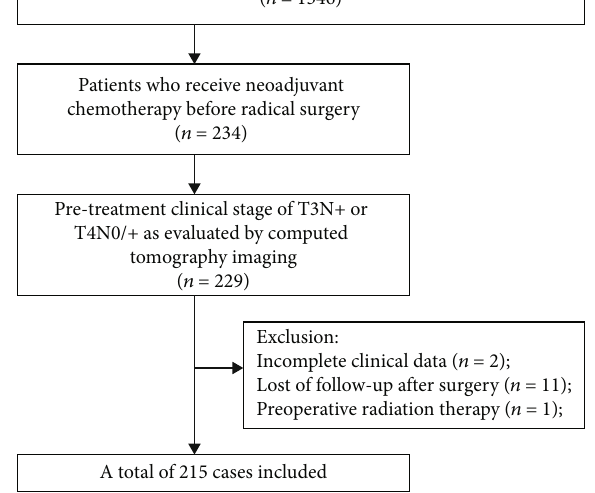
Figure 1: Flow chart of the inclusion and exclusion